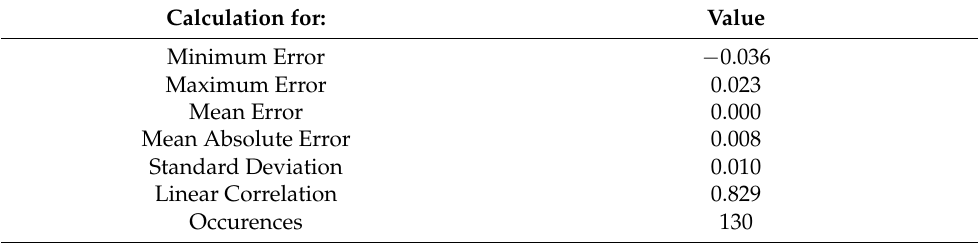
Table 8. Actual vs. predicted values of DLnProduction comparison. Calculation